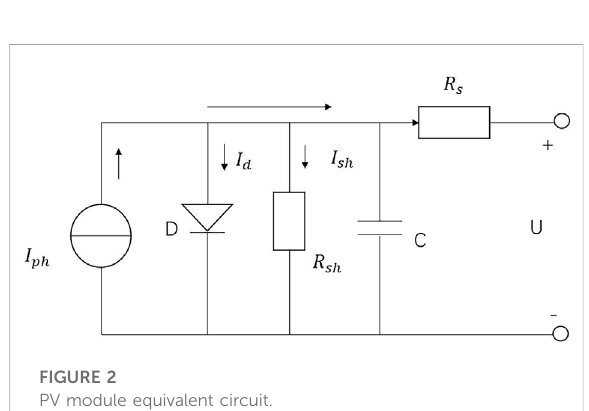
FIGURE 2 PV module equivalent